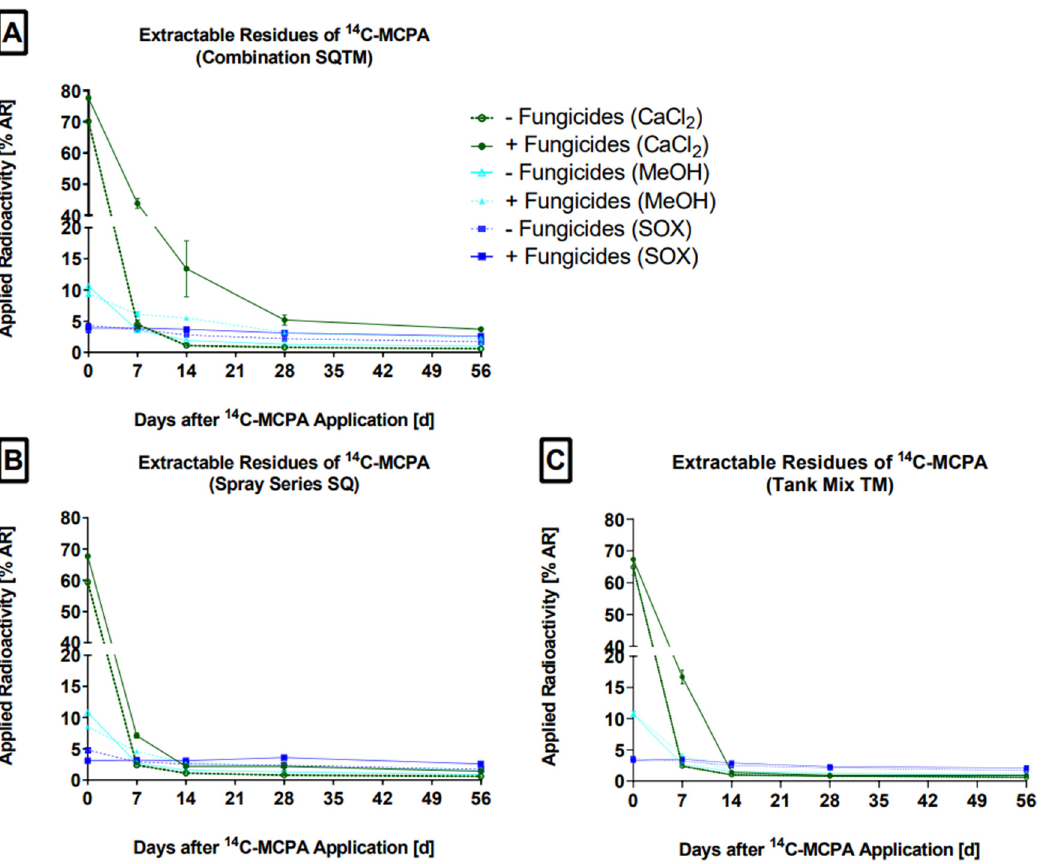
Figure 1. The extractable residues (% AR) of MCPA in the 0.01 M CaCl 2 , MeOH, and Soxhlet (SOX) extracts on days 0, 7, 14, 28, and 56 are presented. ( A ) SQTM − F: control, SQTM+F: combination ( B ) SQ-F: control, SQ+F: spray series and ( C ) TM-F: control, TM+F: tank mix. The mean values and standard deviations were derived from triplicates (n = 3).